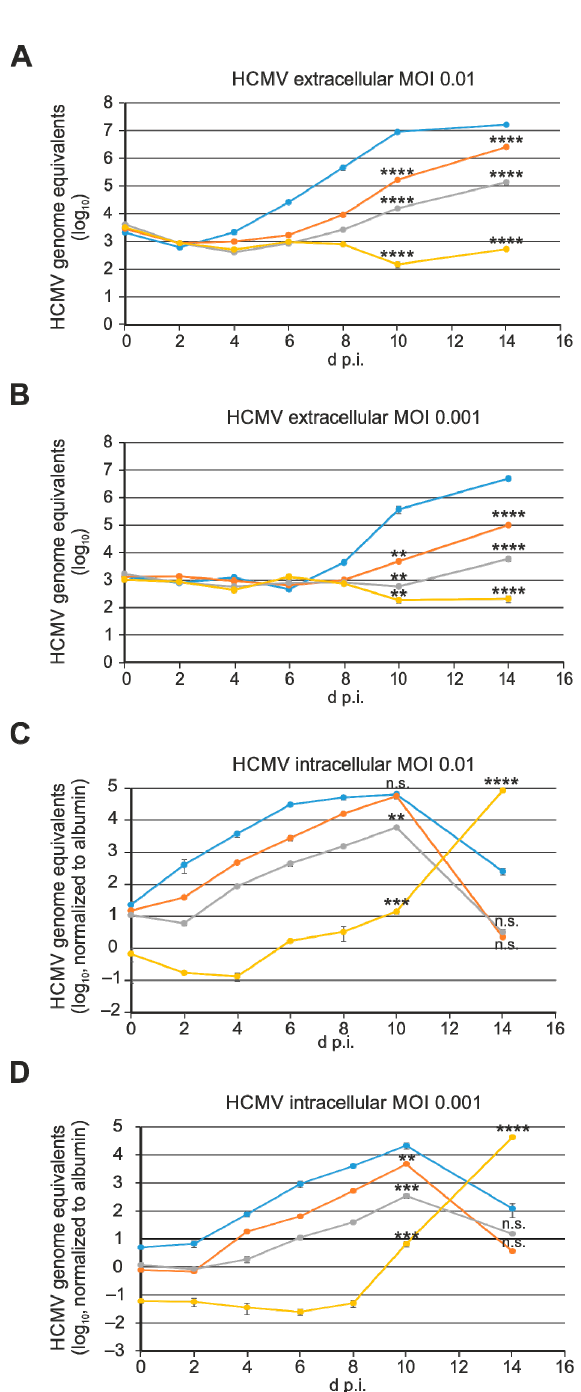
Figure 2. HCMV replication kinetics of the UL97 deletion mutants. HFFs were infected with parental HCMV WT or UL97 mutants at MOI of 0.01 ( A , C ), or 0.001 ( B , D ). Viral supernatants were harvested at indicated time points and viral genome equivalents were determined by qPCR ( A , B ). Alternatively, cells were harvested at indicated time points and intracellular viral genome equivalents were determined together with albumin as housekeeping gene via qPCR. Subsequently, HCMV genome equivalents were normalized to albumin signals ( C , D ). Each value is given as a mean of quadruplicates and standard errors of mean (SEM) are shown. Statistical analysis was performed using ordinary one-way ANOVA and Dunnett’s test compared to HCMV UL97 WT. ****, p < 0.0001; ***, p < 0.001; **, p < 0.01; n.s., not significant.